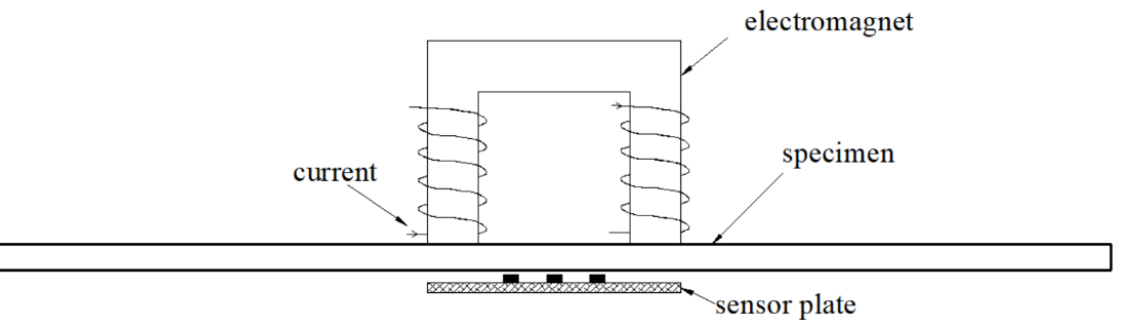
Figure 3. Sketch of the measurement.